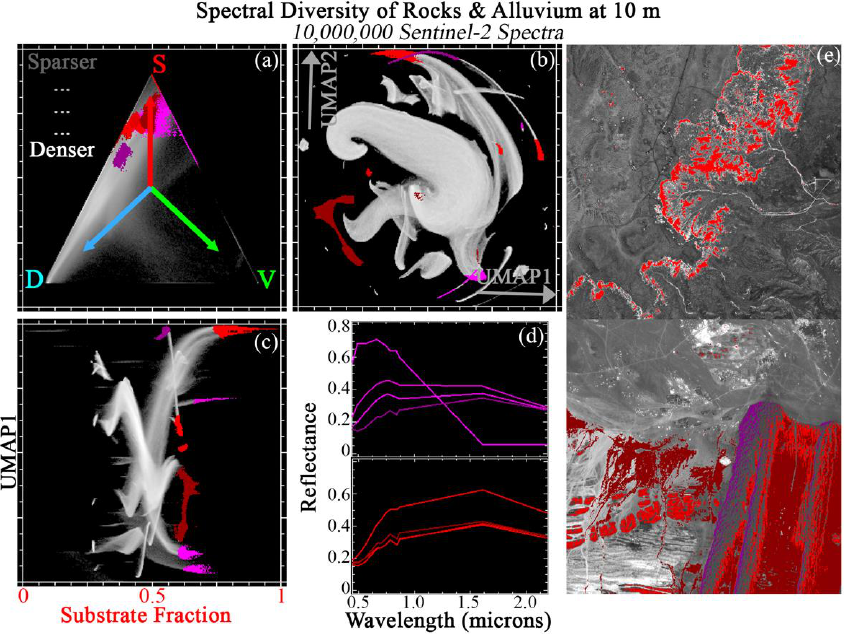
Figure 14. Joint characterization of rocks and alluvium (2). 10 × 1 megapixel Sentinel-2 tile subsets are selected from global geology hotspots and analyzed at full 10 m pixel resolution. These spectra preferentially occupy the S to D apexes of the SVD mixing space ( a ), leaving the V portion of the space relatively sparse. The global 3-endmember linear mixture model fits these spectra less well than the agricultural spectra (here, 98.5% of spectra with <5% RMSE). UMAP ( b ) captures both sub- tle mixing continua and discrete clusters, but does not offer physical interpretability. Joint charac- terization ( c ) uses the physical meaning of the Substrate mixture fraction to contextualize the subtle statistical relationships captured by UMAP. Example regions of interest are identified from the joint space and projected onto the ternary mixing and UMAP spaces. Mean spectra for each region ( d ) illustrate similarities and differences among statistically distinct clusters. Clusters identified by joint characterization also frequently show geographic coherence ( e ). 4. Discussion With these results in mind, we structure our discussion in three parts. First, we revisit each fundamental science question that motivated the analysis. Next, we present a con- ceptual explanation for the efficacy of the method. We then close with a brief discussion of limitations, avenues for future work, and concluding remarks. 4.1. Revisiting the Motivating Questions 4.1.1. Question 1: Variance-Based Characterization & Modeling The first set of questions addressed by this study concerned the overall SVD fraction (and misfit) distributions of globally significant land cover classes. The SVD fraction ques- tion is addressed by the ternary diagrams shown in the upper left of each of Figures 4 – 14. We summarize these in Figure 15, showing the SVD distribution for each category (outer plots), as well as the merged global distribution of the entire mosaic (center left). Clearly, the land cover categories used in this study occupy overlapping subsets of the global SVD space. This is in part because spectral mimicking may render distinct reflectances